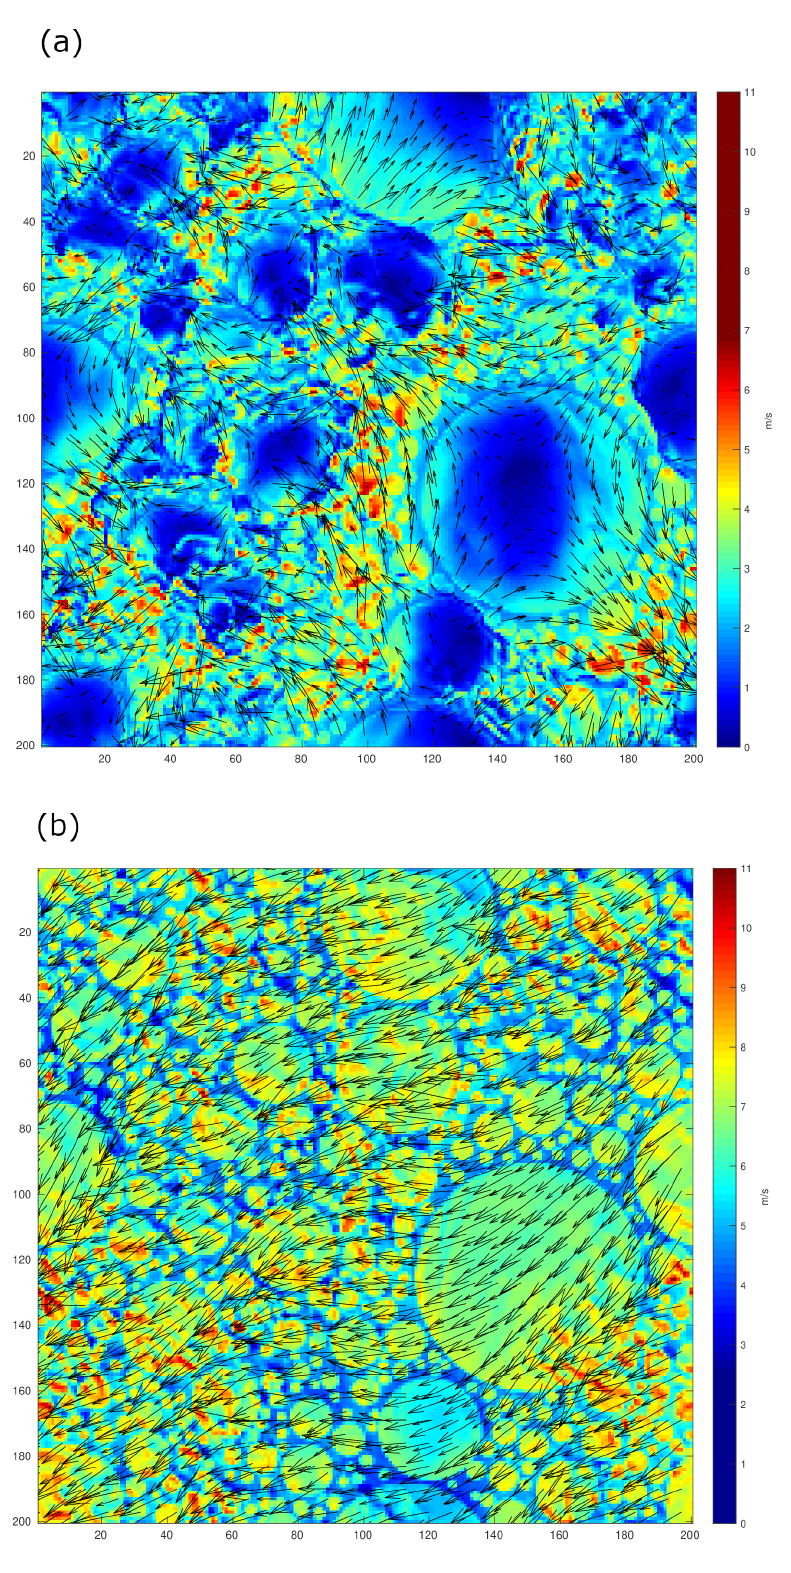
Figure 2. Wind speed (colors) and wind vectors (arrows) for simulations with c = 70%, N f = 500, with weak wind conditions (profile No. 1; a ) and stronger wind conditions (profile No. 3; b